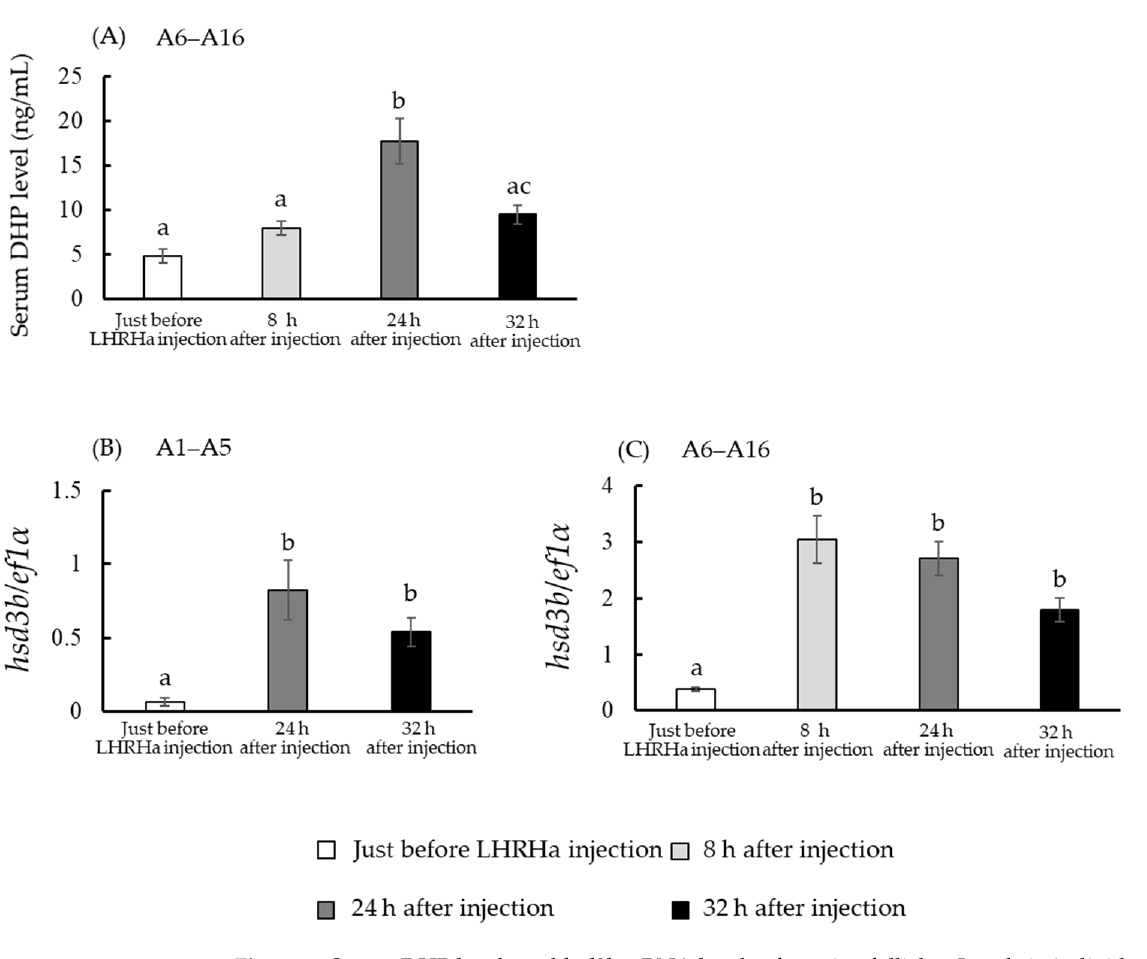
Figure 5. cyp17a1/2 mRNA levels of ovarian follicles. Levels in individuals (A1–A16) just before (white column), and 8 h (light gray column), 24 h (dark gray column), and 32 h (black column) after injection. Some individuals (A1–A5) did not reach ovulation, while other individuals (A6–A16) did. Panels ( A ) and ( C ) show cyp17a1 and cyp17a2 mRNA levels between individuals A1–A5. Panels ( B ) and ( D ) show cyp17a1 and cyp17a2 mRNA levels between individuals A6–A16. Different letters rep- resent a significant difference among groups ( p < 0.05).